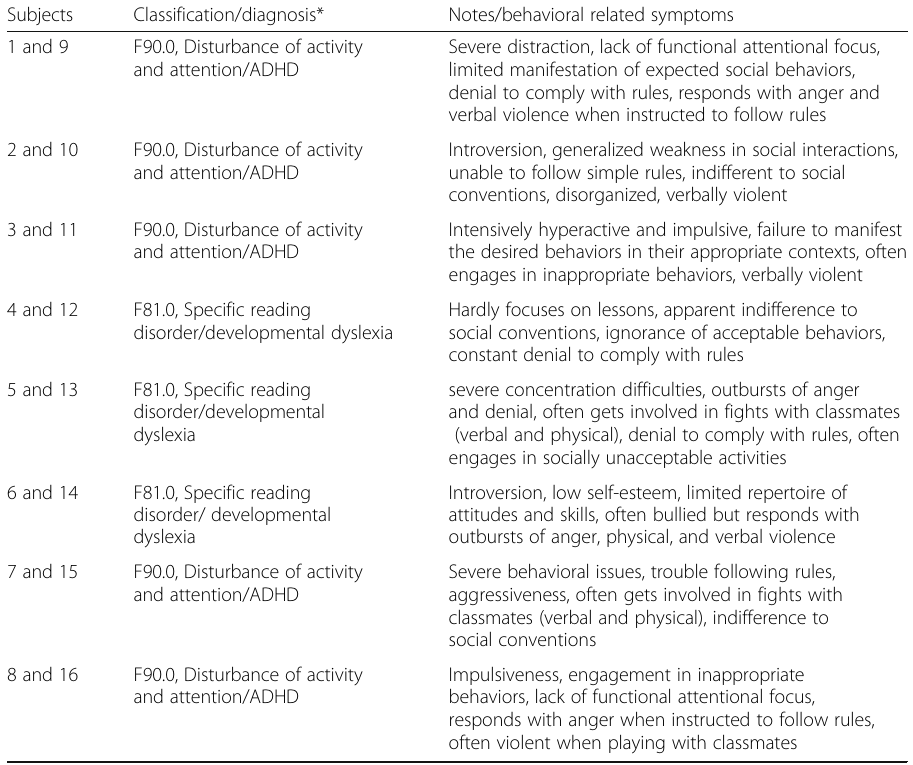
Table 1 The study ’ s